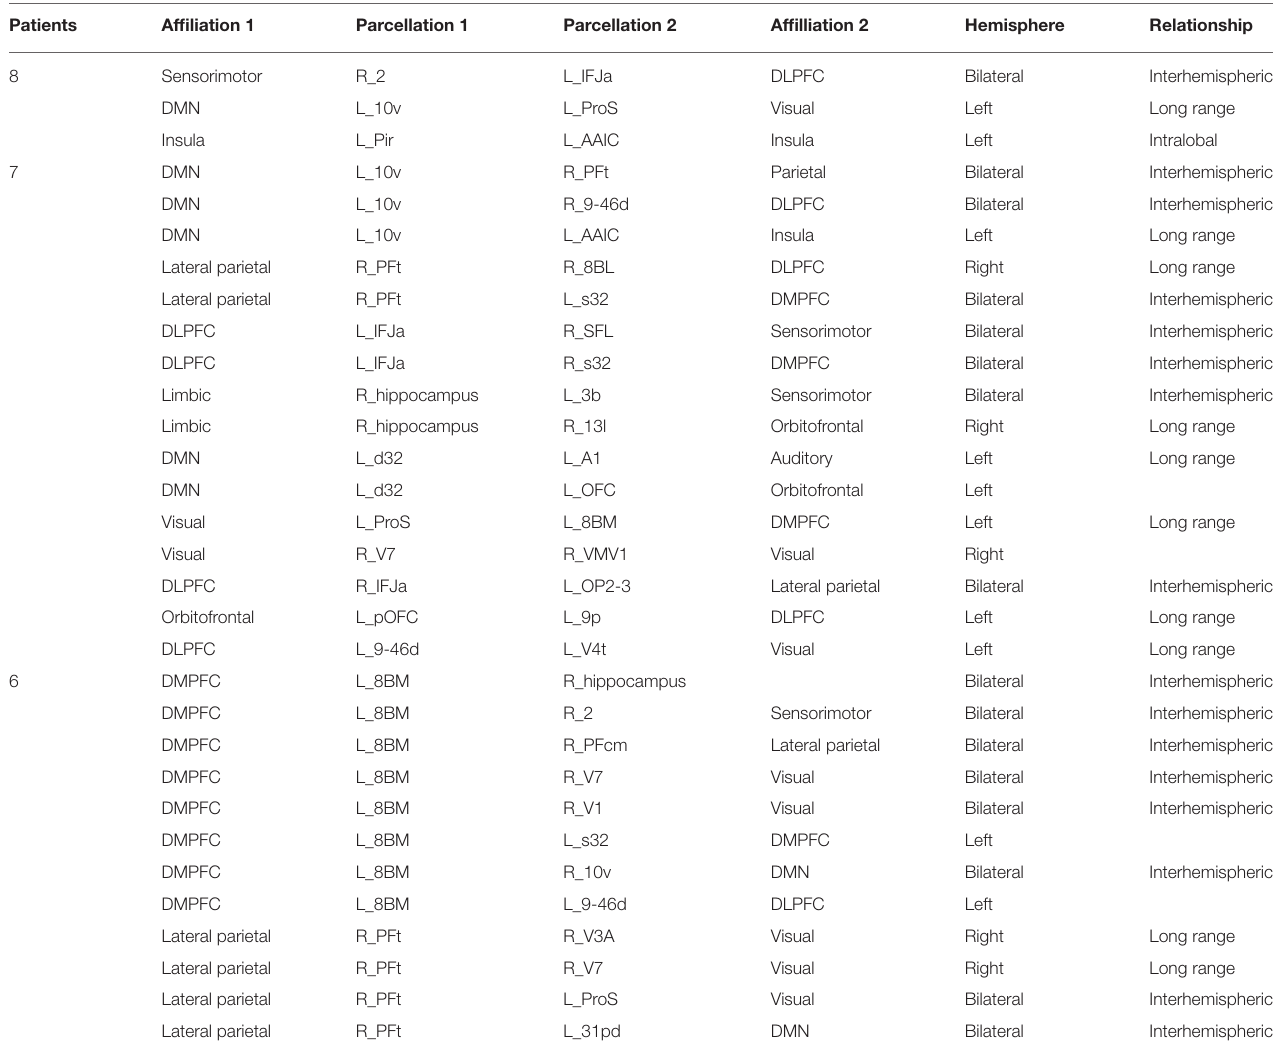
TABLE 5 | Frequency of functional anomalies.